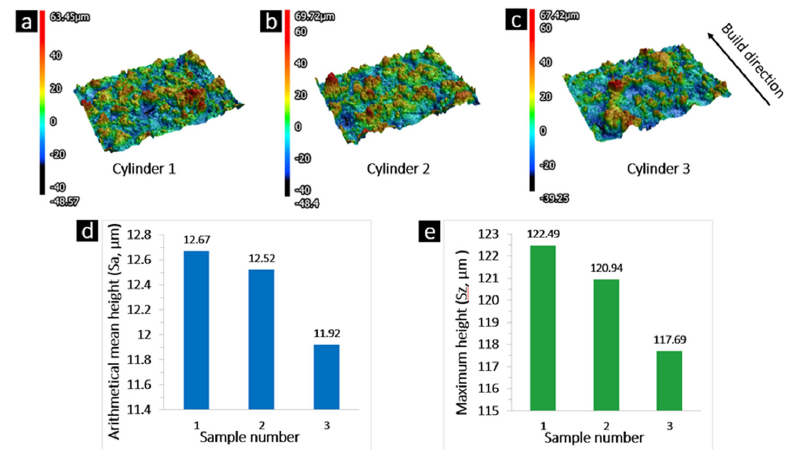
Figure 7. Surface profiles of Cylinders 1, 2, and 3 ( a , b , c ). Average arithmetical mean height (Sa) ( d ), and average maximum height (Sz) ( e ) for Cylinders 1, 2, and 3. and average maximum height (Sz), ( e ) for Cylinders 1, 2, and